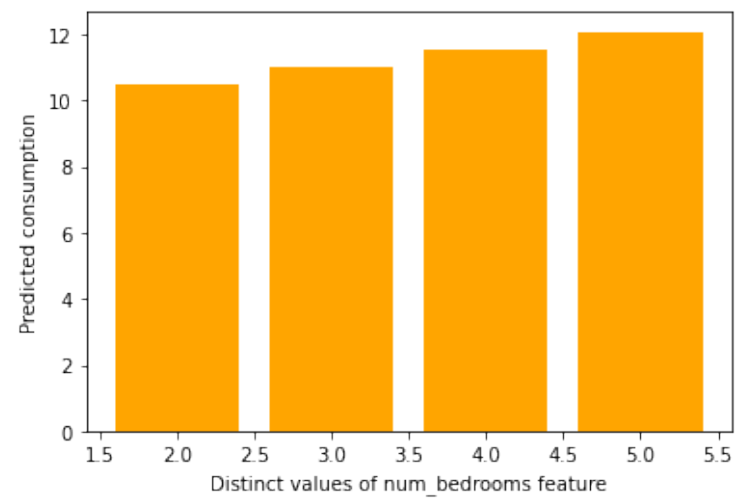
Figure 12. Impact of the number of bedrooms on the energy consumption.